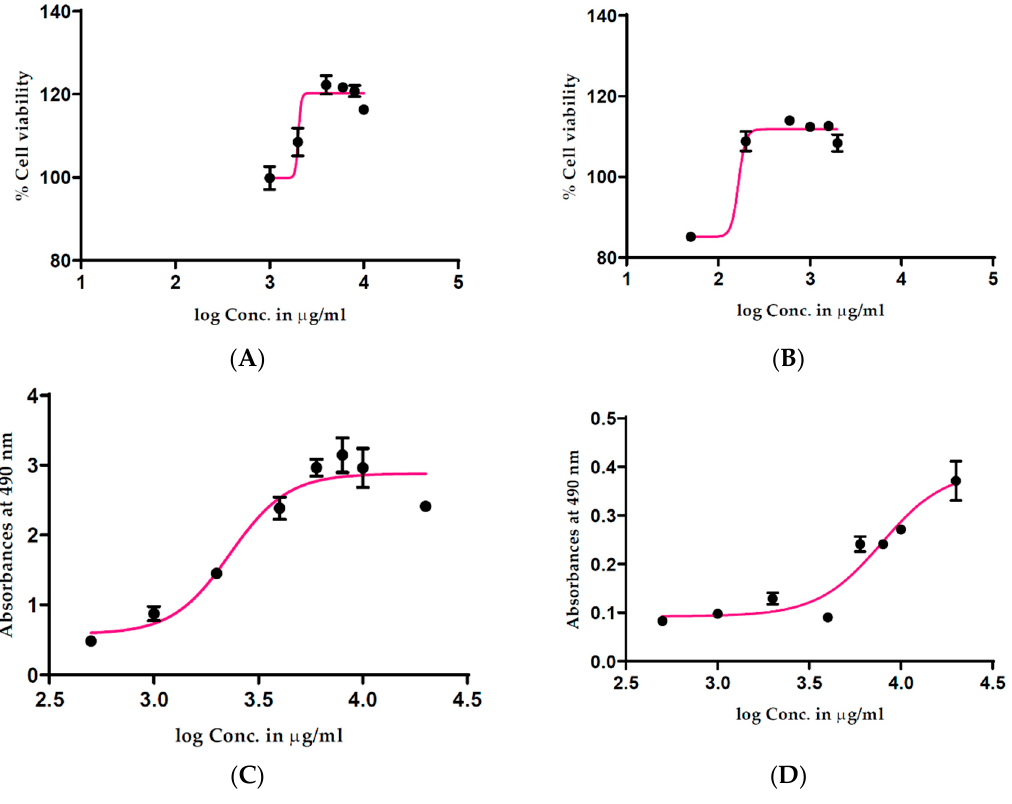
Figure 1. Effect of T. ferdinandiana methanolic ( A ) and water ( B ) extracts of fruits on HT29-MTX-E12 cell viability measured using the CellTiter 96 ® AQ ueous One Solution Cell Proliferation Assay, and in a cell- free system ( C and D ), respectively. All concentrations were tested in triplicate with mean values ± SEM used to construct dose–response curves. Conc. denotes concentration.